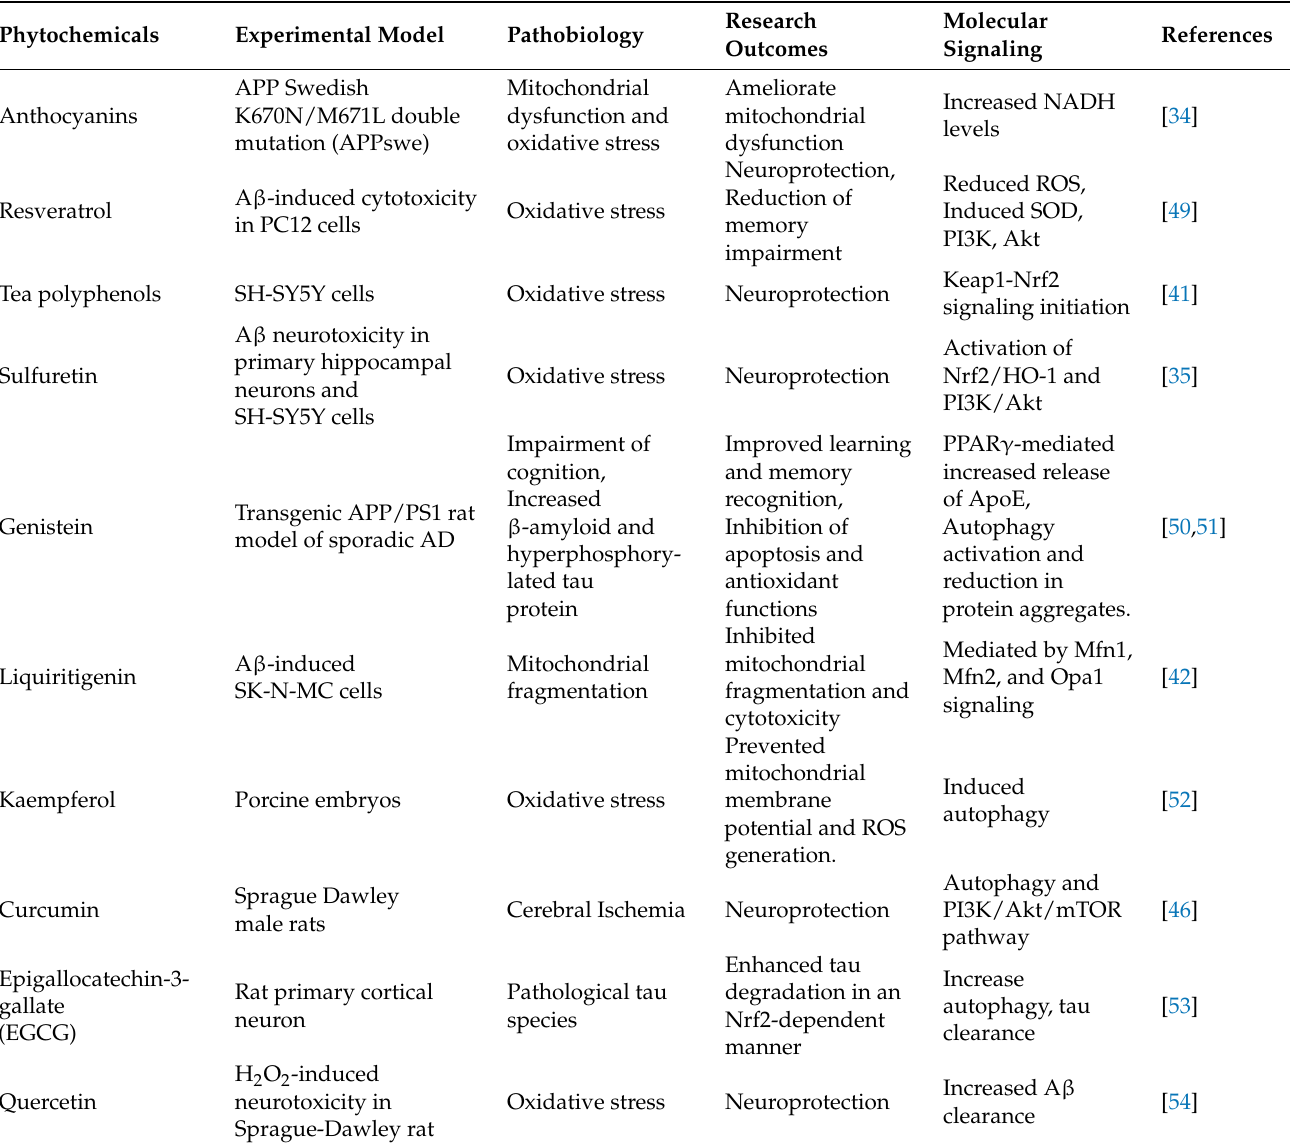
Table 1. Different phytochemicals mitigating mitochondrial dysfunctions in AD